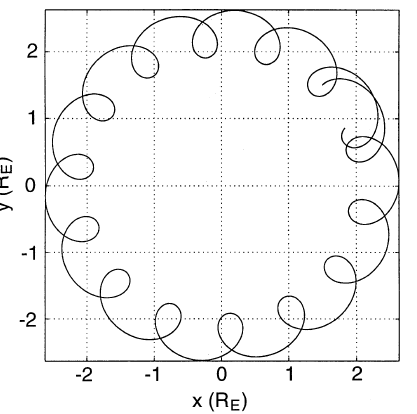
Fig. 2. Planar equatorial trajectory of a proton (300 keV) in a zonal octupole magnetic field ( m (cid:136) 0, n (cid:136) 3; g 30 (cid:136) 1315 nT)